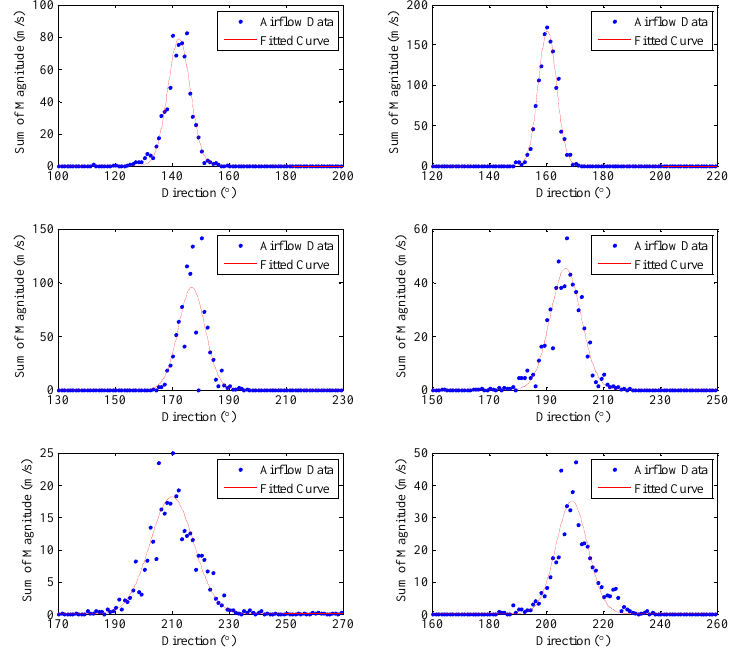
Figure 13. Distribution of airflow in the testbed.